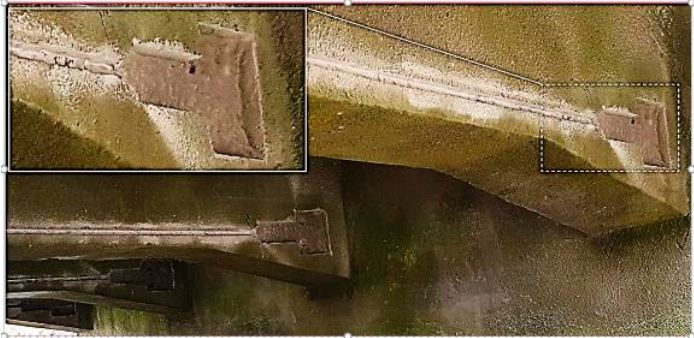
Table 2. Properties of the flexible adhesive.